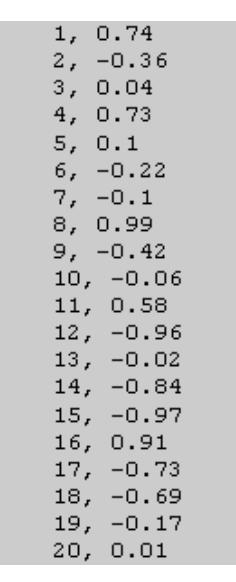
Fig 3. First 20 results of sea level